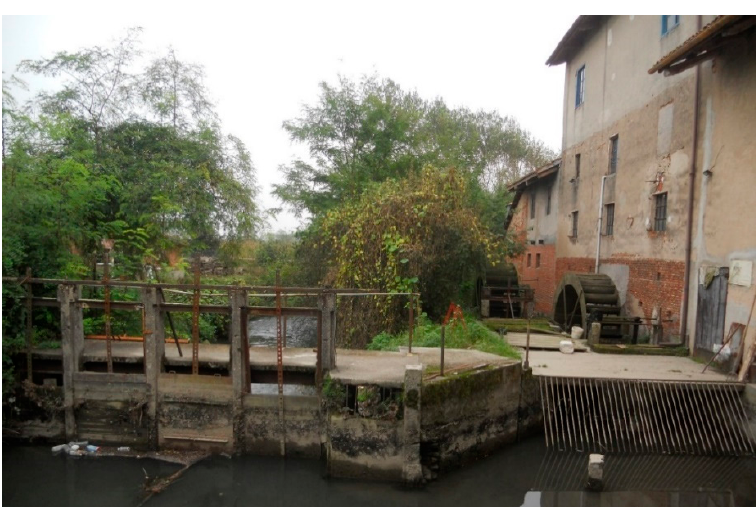
Figure 3. Forno mill: The water inlet and the two water wheels.